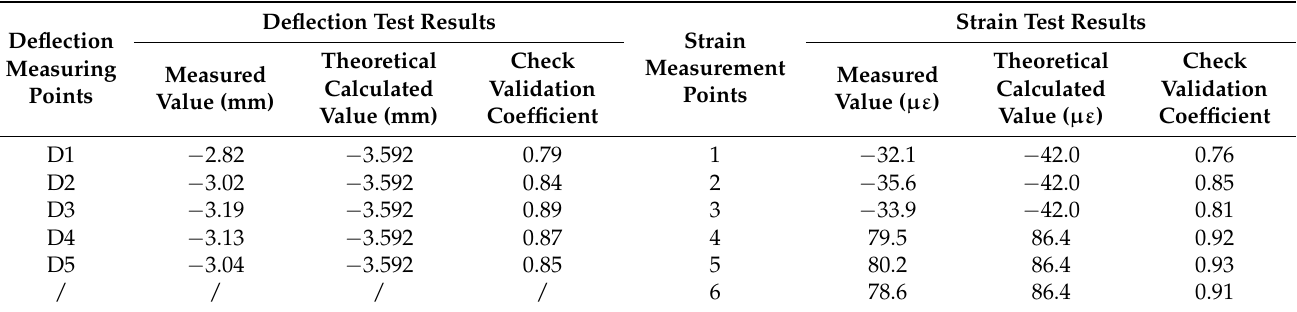
Table 6. The girder deflection and strain test